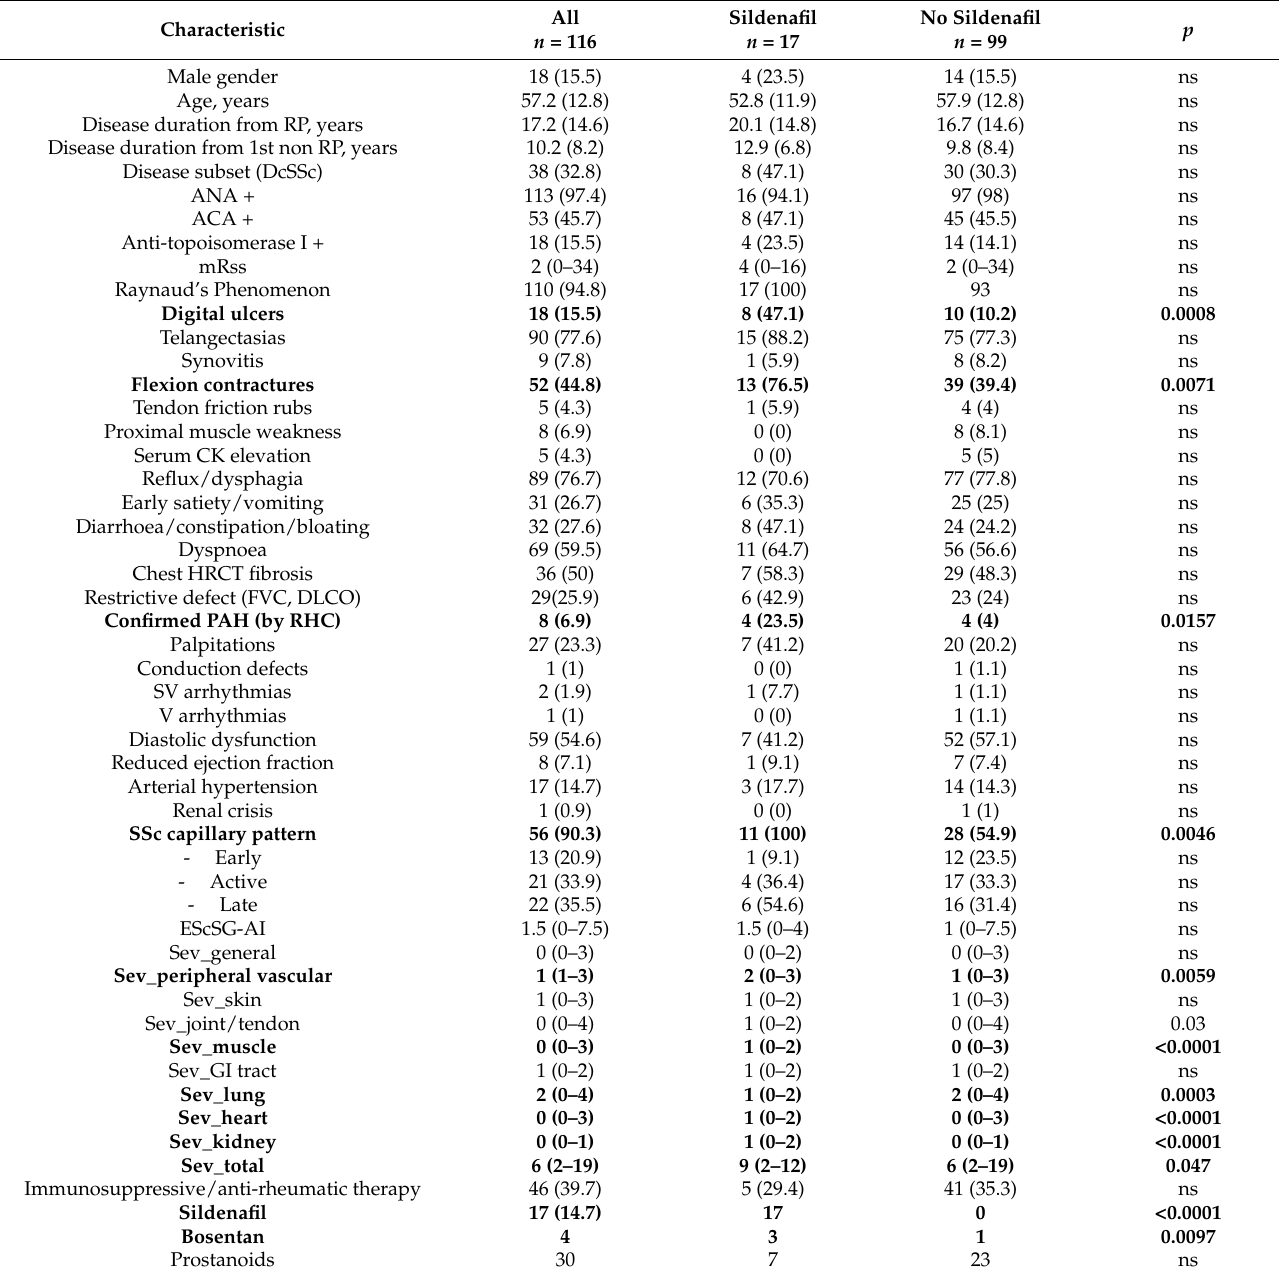
Table 1. Clinical features of the 116 SSc patients. Data are shown as mean ± standard deviation (SD), as median (range) or as number (percentage). The number in parentheses refers to the percentage of patients with the specific feature among the total patients with the available test results. Difference between groups were analyzed by Fisher’s exact test and unpaired t -test or Mann–Whitney test as appropriate. Clinically relevant criteria highlighted in